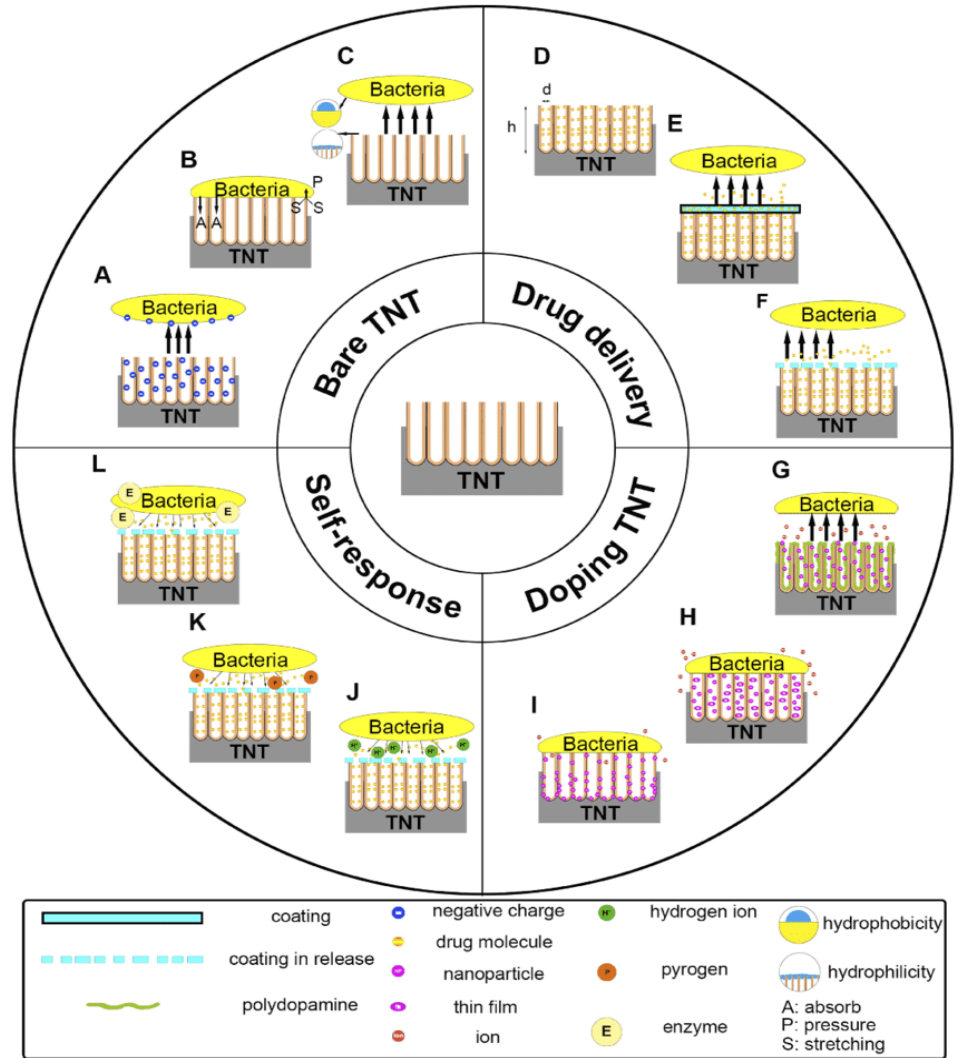
Figure 8. Mechanisms of antibacterial application of TNTs in orthopedic implants. Reproduced from [117].